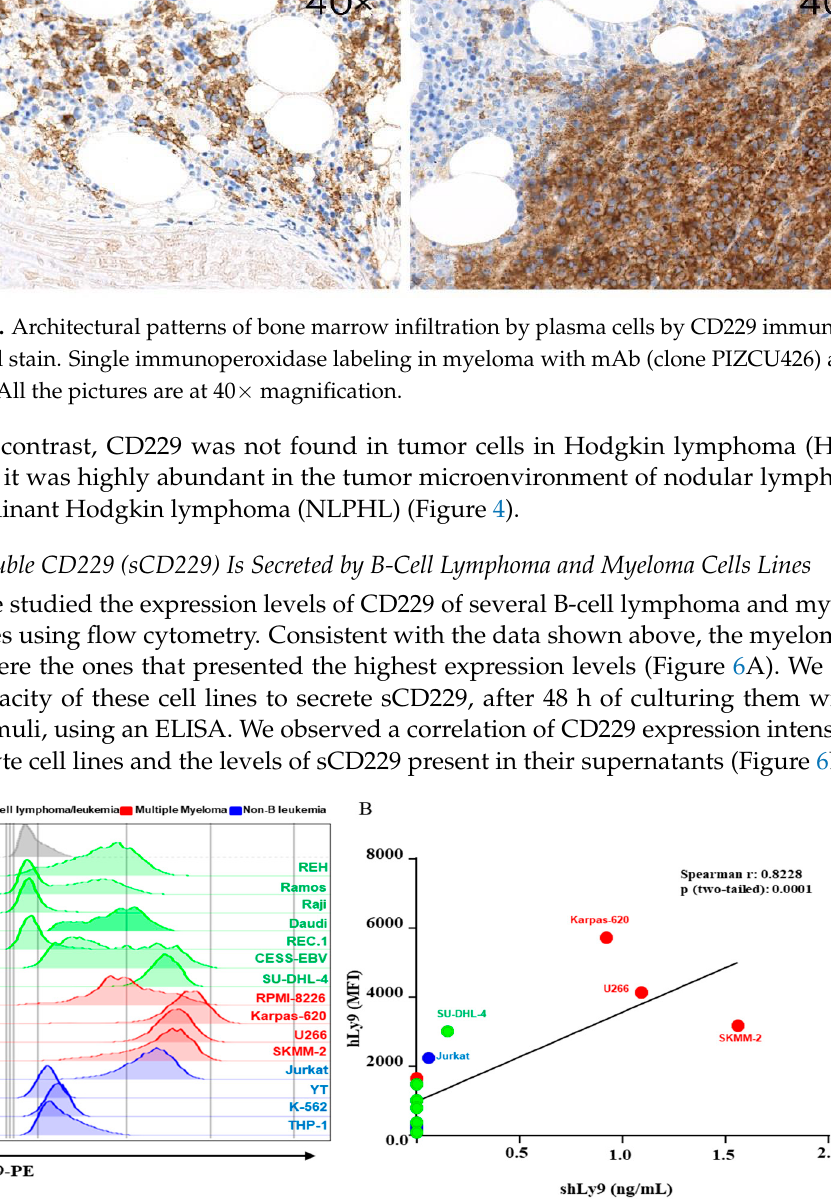
Figure 6. Expression levels of CD229 on cell lines. ( A ) Expression of CD229 on several leukocyte cell lines using flow cytometry. ( B ) Correlation of cell-surface expression (mean fluorescence intensity- lines using flow cytometry. ( B ) Correlation of cell ‐ surface expression (mean fluorescence intensity ‐ MFI) and sCD229 as determined by ELISA. MFI) and sCD229 as determined by